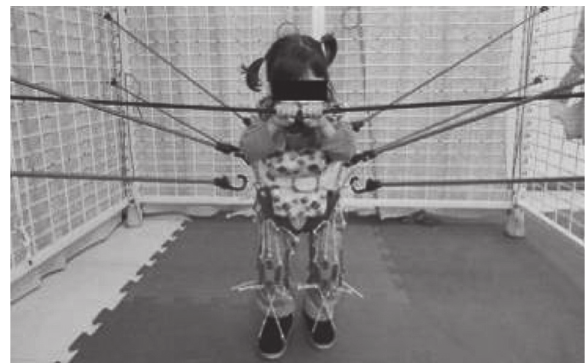
Figure 4 - Patient alone at spider cage with the bungee cords Source: Research